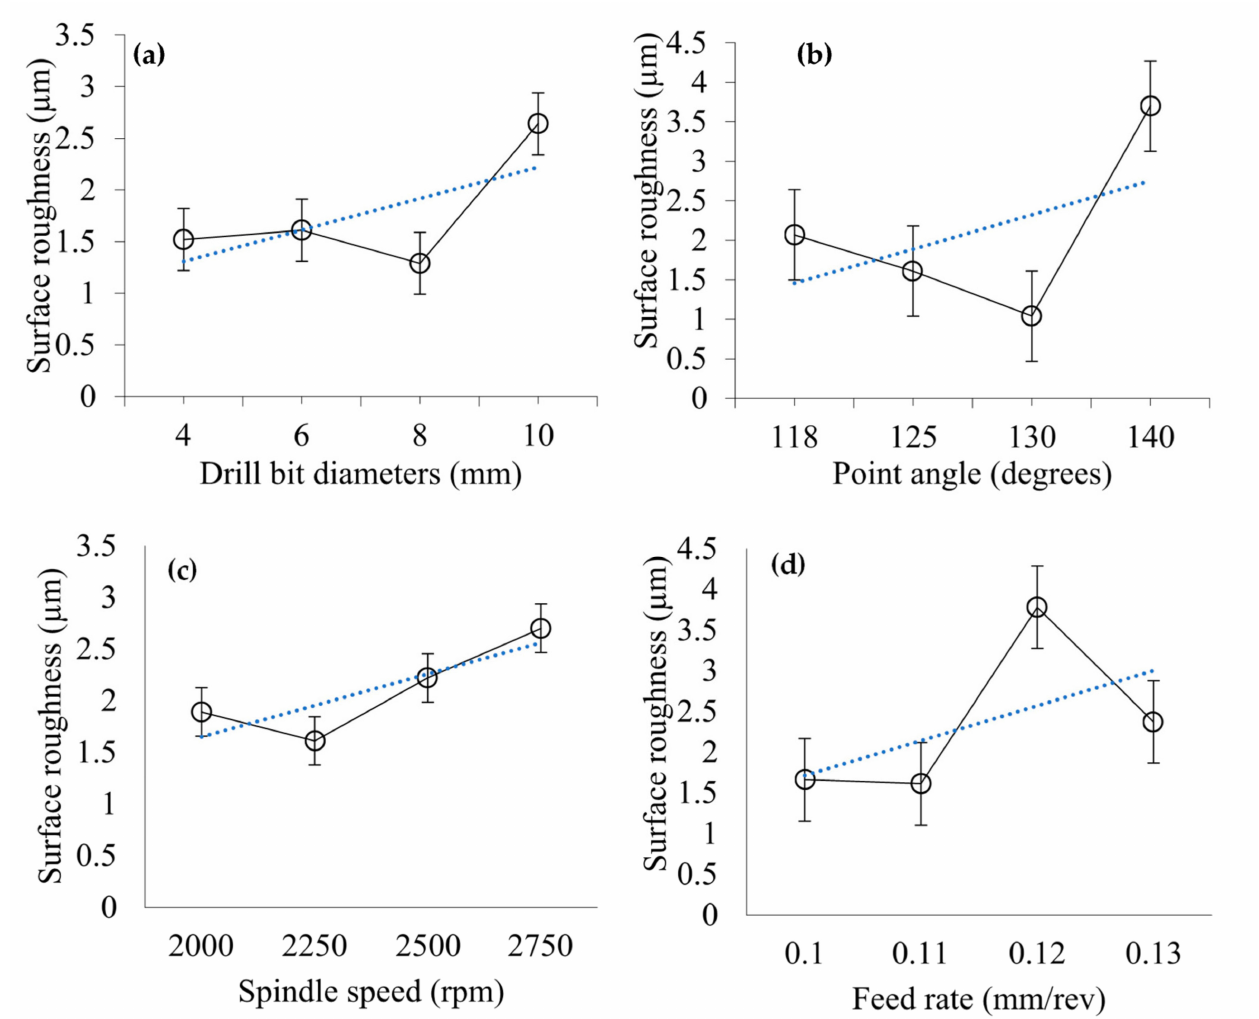
Figure 4. ( a , b ) Effect of drill bit diameter (at point angle 125 ◦ ) and point angle (at drill bit diameter 6 mm) on surface roughness with 6 Scotch tape layers at the spindle speed of 2250 rpm, and feed rate of 0.11 mm/rev, ( c , d ) Effect of spindle speed (at feed rate 0.11 mm/rev) and feed rate (at spindle speed 2250 rpm) on surface roughness at drill bit diameter of 6 mm, point angle of 125 ◦ with 6 Scotch tape